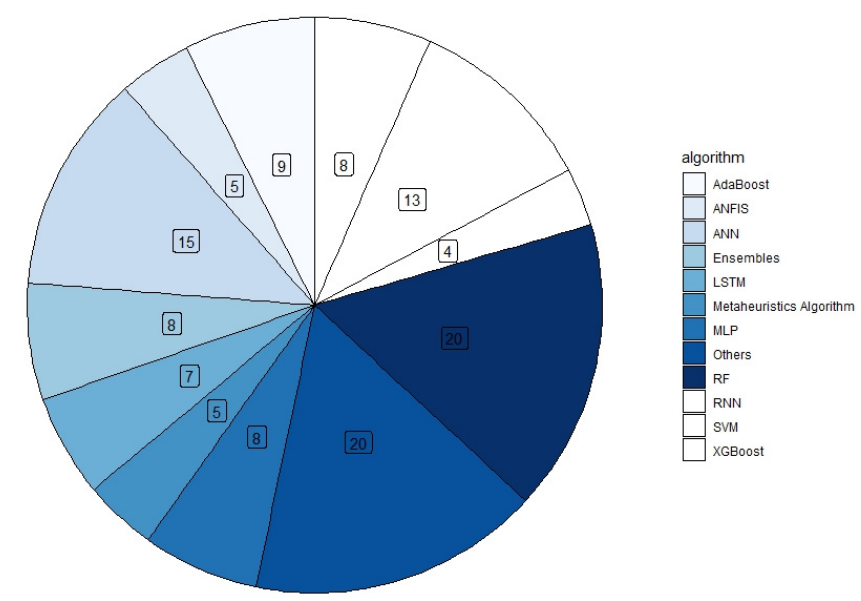
Figure 9. Number of times ML approaches were employed in studies. Table 6. Performance metrics and their proportions.